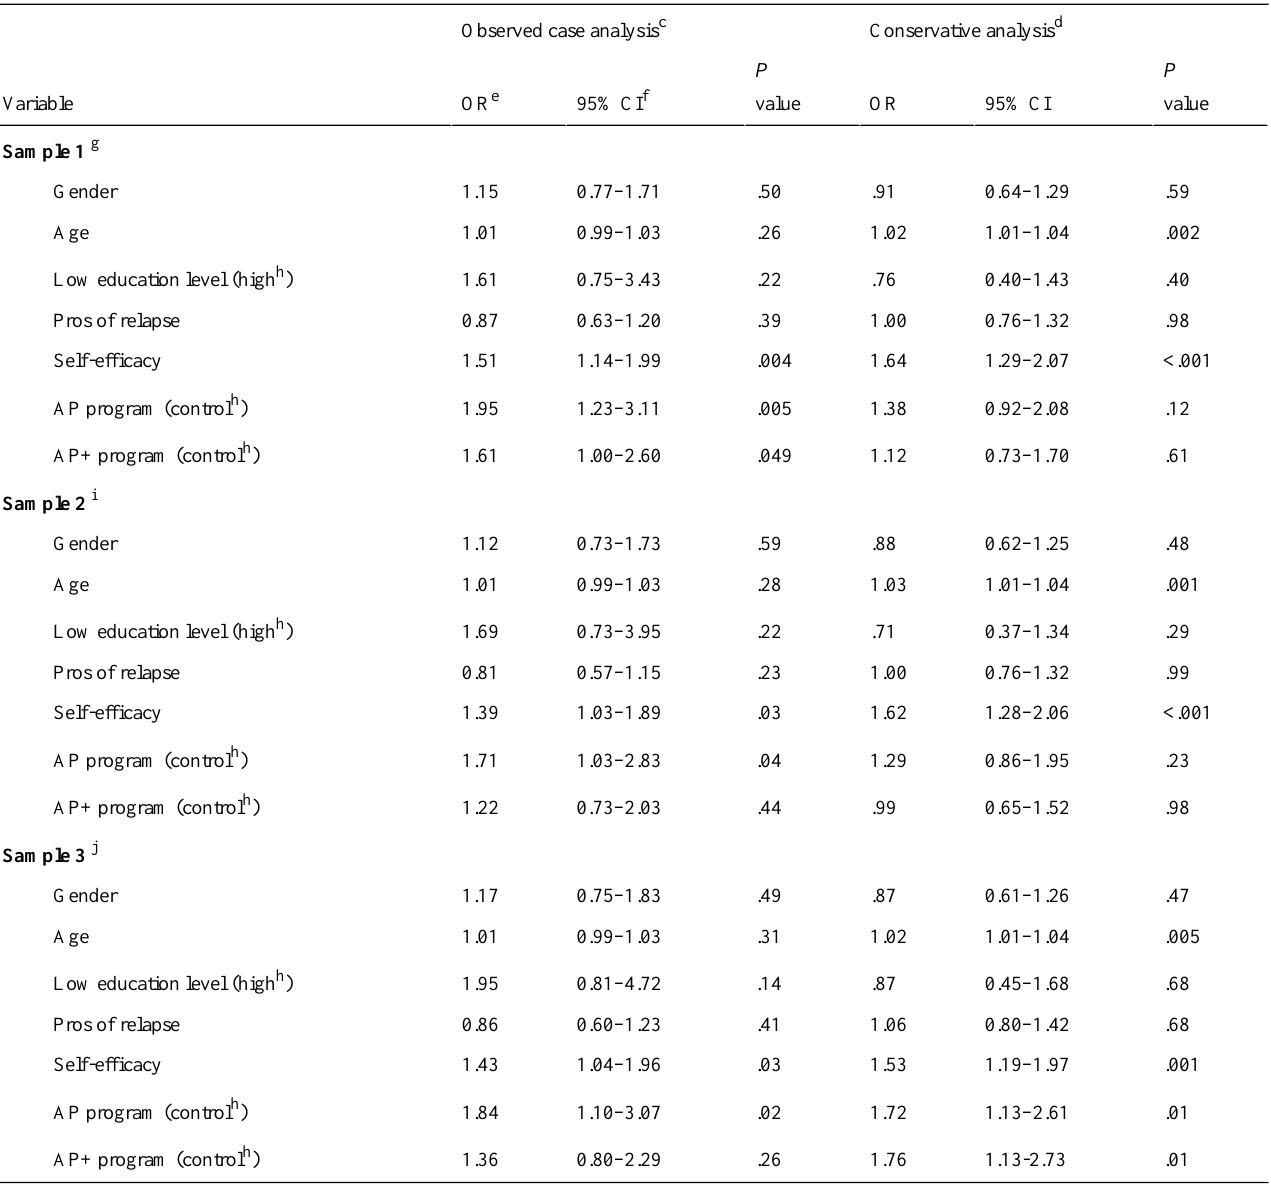
Table 3. Regression 12-month continued abstinence on the AP a and AP+ b program in sample 1 (observed cases, n = 559; conservative analysis, n = 1974), sample 2 (observed cases, n = 412; conservative analysis, n = 1757), and sample 3 (observed cases, n = 383; conservative analysis, n =